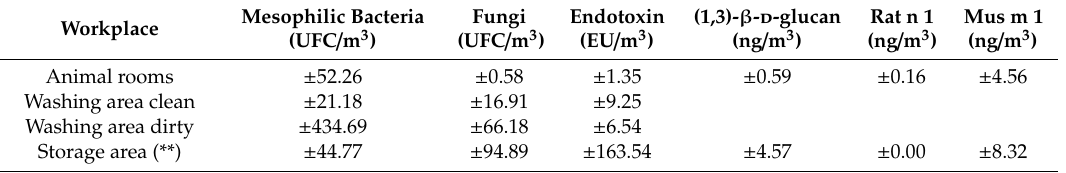
Table 2. Uncertainty measurement (*) for sampled biological agents by working areas. Mesophilic Bacteria Workplace (UFC / m 3 ) Animal rooms ± 52.26 Washing area clean ±